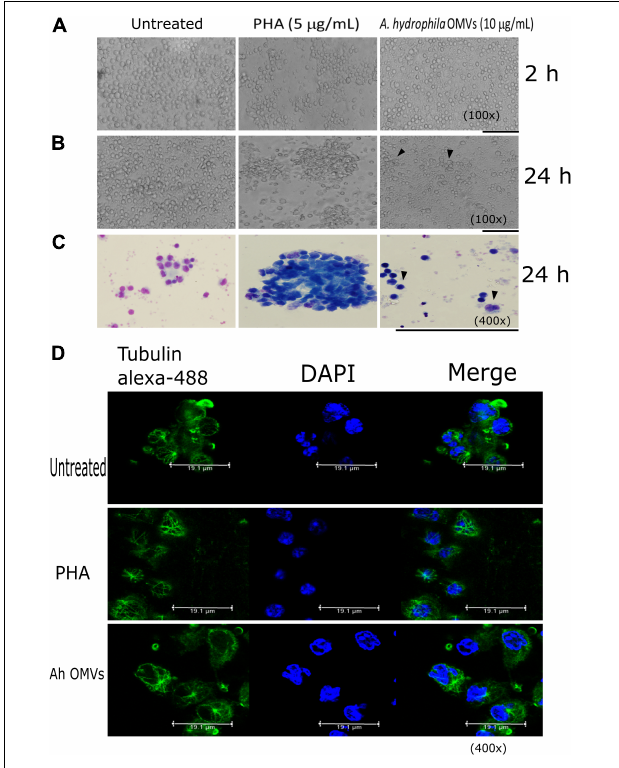
FIGURE 7 | Morphological alterations induced by A. hydrophila ATCC R (cid:13) 7966 TM OMVs in PBMCs. (A) After 2 h post-stimulation with A. hydrophila OMVs, no morphology changes of the PBMCs were observed compared with PBMCs after 24 h post-stimulation with vesicles, after 24 h post-stimulation conglomerated cells were observed (arrowheads) (B) . Giemsa staining revealed differences in the affinity of the dye to the nucleus and cytoplasm, bigger cells, and vacuolization of the stimulated PBMCs with A. hydrophila OMVs (arrowheads) (C) . Confocal microscopy, showed defective tubulin polymerization in PBMCs stimulated with OMVs (D) . bars = 50 µ